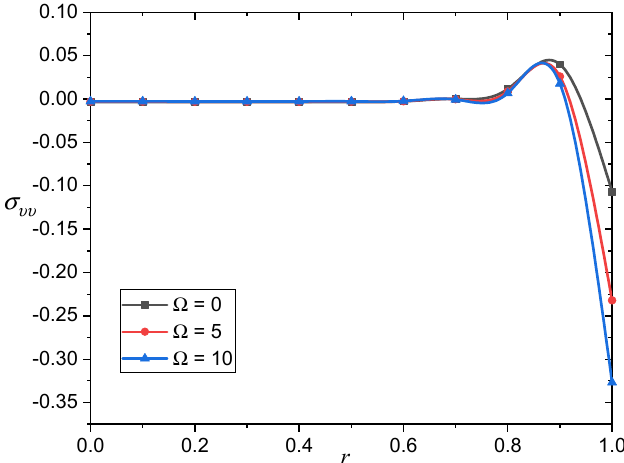
Figure 10. The radial stress variation (cid:2026) (cid:3045)(cid:3045) for different rotation parameter Ω .